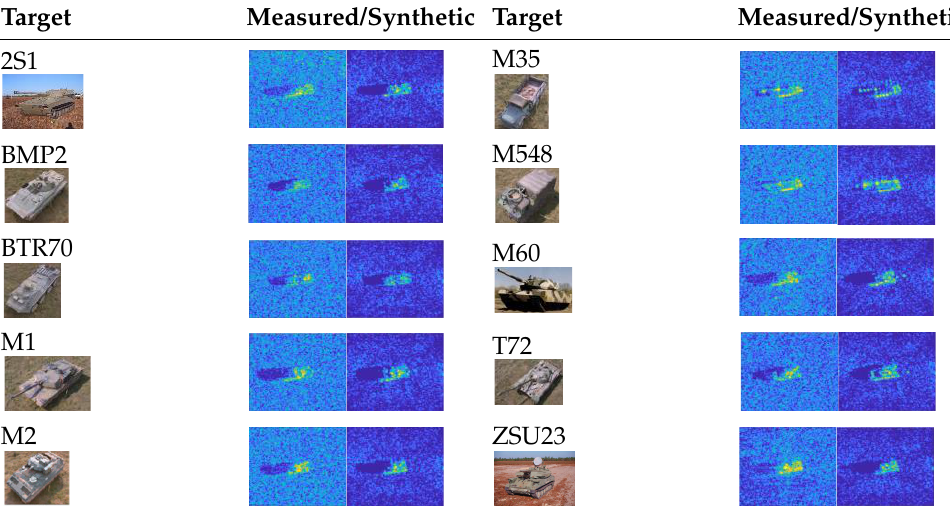
Table 1. Comparison of measured and synthetic SAR imagery in SAMPLE dataset.